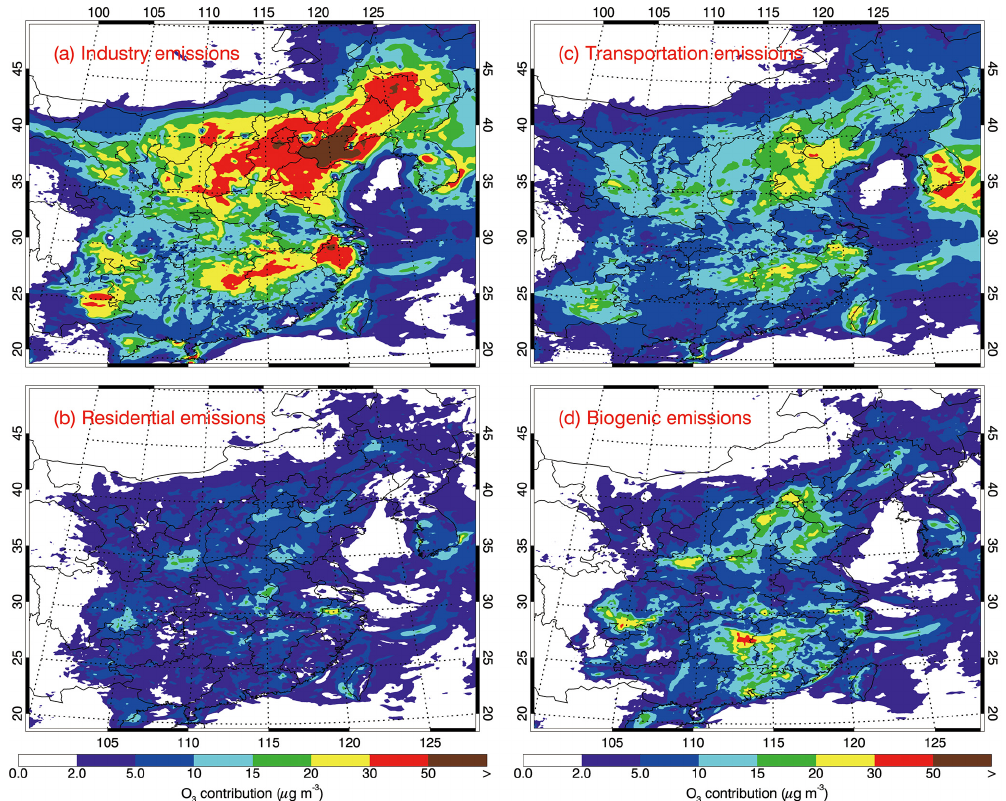
Figure 8. Distributions of the contribution to near-surface [O 3 ] averaged in the afternoon during the whole episode from (a) industry, (b) residential, (c) transportation, and (d) biogenic